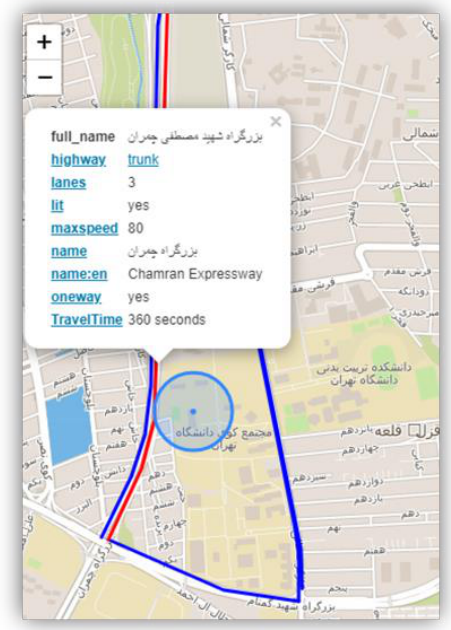
Figure 3. Visualization of nearest way to the user’s current position and relevant transportation information